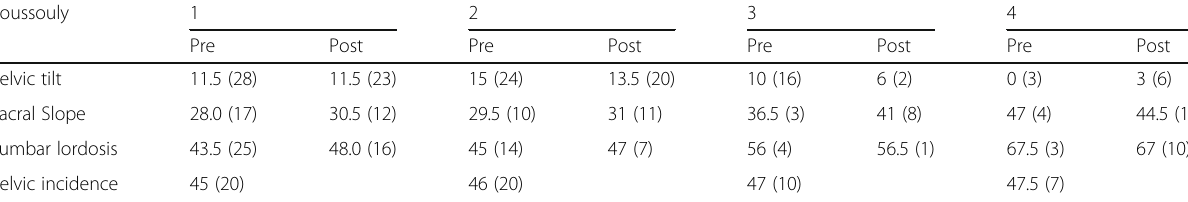
Table 3 Sagittal measurements. Patients grouped according Roussouly et Al, pre- and post-operative median measurements with (range) Roussouly 1 2